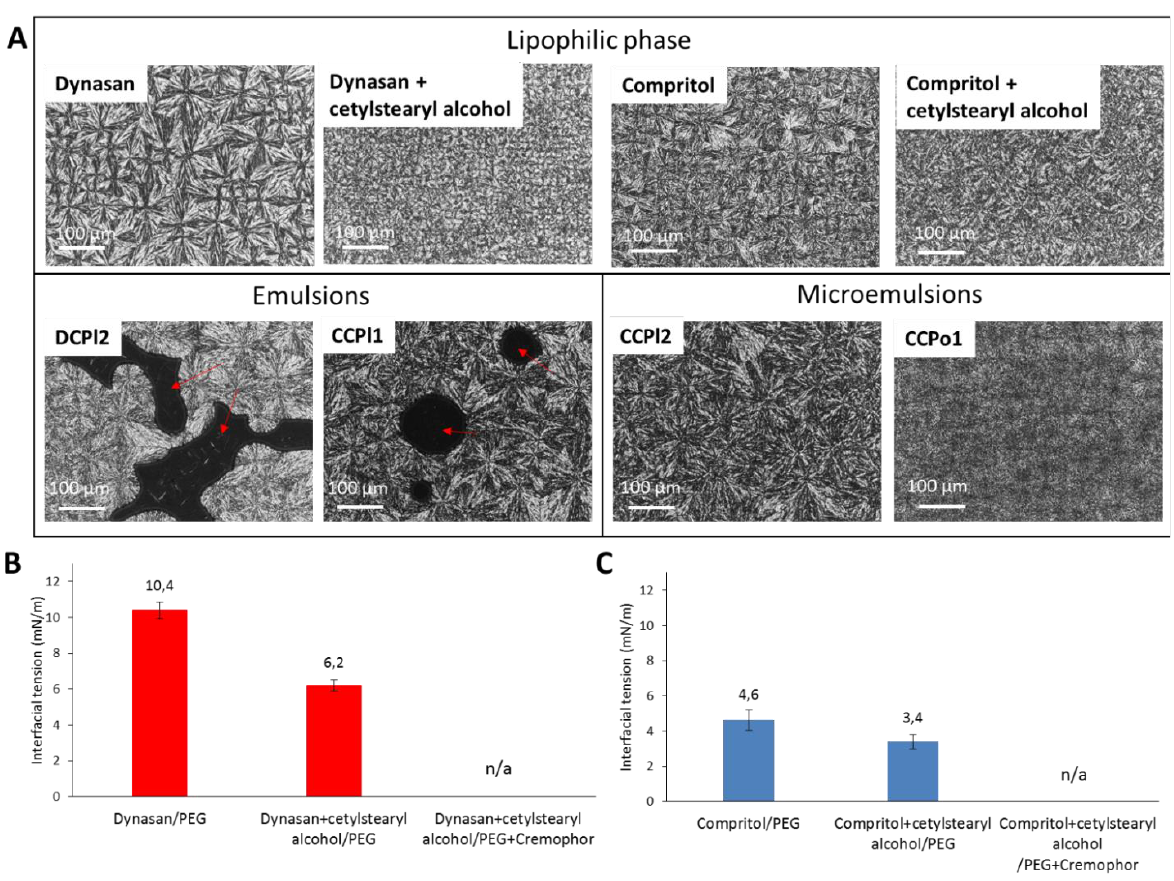
Figure 3. HS-PLM images of lipophilic phase (main lipids without and with cetylstearyl alcohol), examples of Dynasan-based and Compritol-based melt emulsions and Compritol-based melt mi- croemulsions. Dark areas relative to liquid PEG are marked with red arrows. ( A ). Interfacial tension values of Dynasan-based ( B ) and Compritol-based ( C ) biphasic